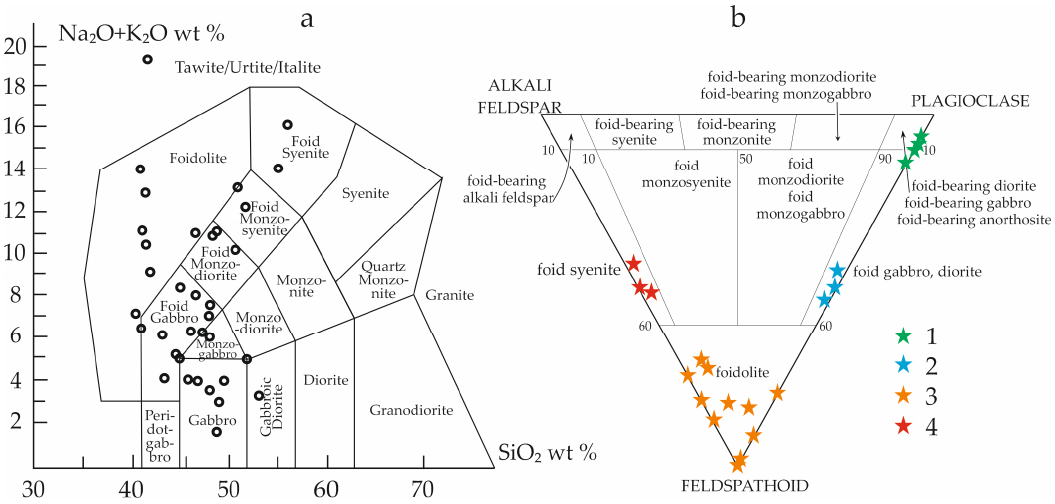
Figure 7. Classification of silicate rocks of the University pluton. ( a ) On the (TAS) diagram, the classification fields are given according to [67] and ( b ) classification of plutonic rocks in the system (APF) according to modal content of minerals in volume percent according to [68]. The stars indicate: 1 = subalkaline gabbro ca. 490 Ma and subalkaline gabbro-dolerites; 2 = leucotheralites; 3 = foidolites ca. 390 Ma; 4 = nepheline and alkaline syenites ca. 390 Ma.